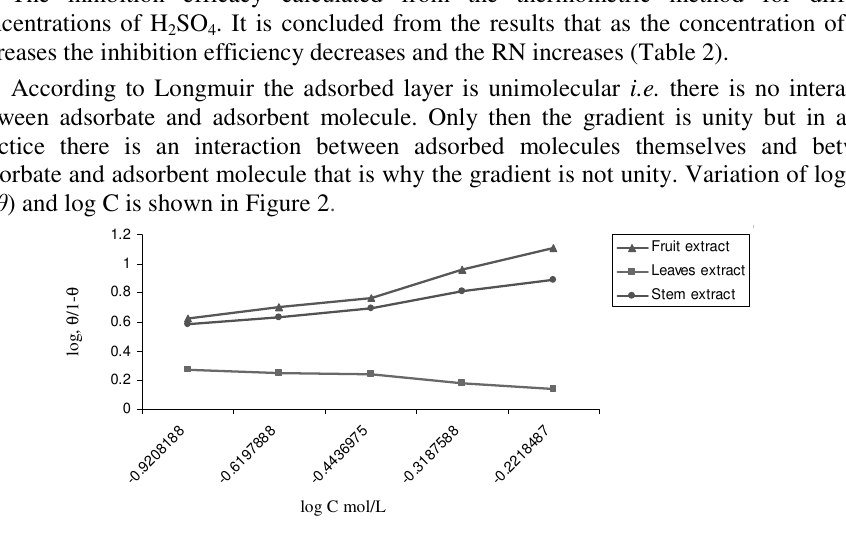
SO ) with alcoholic 2 4